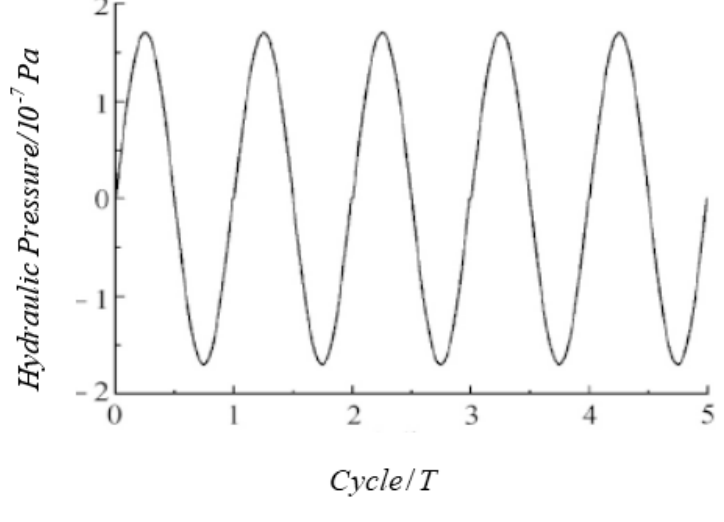
Figure 7. Dynamic load curve of vibrator.